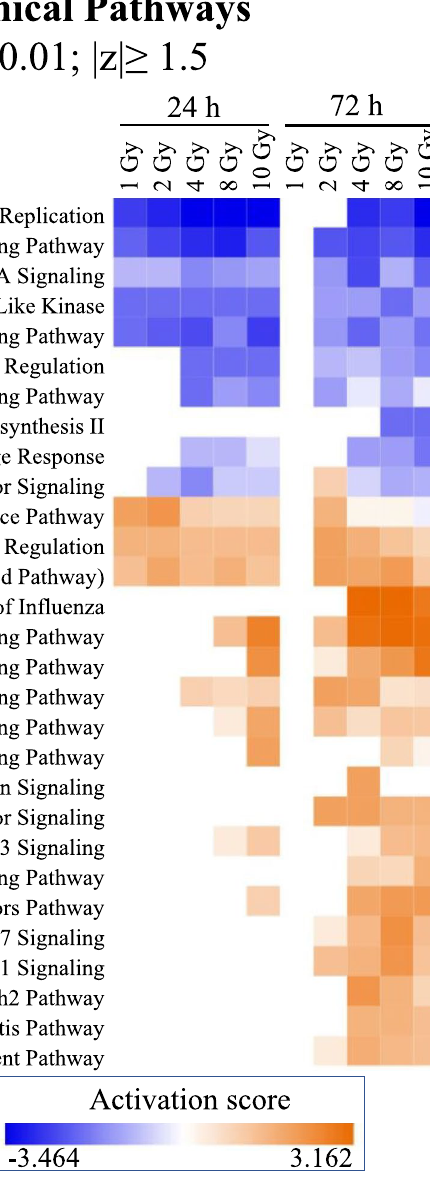
Figure 8. Comparison across canonical pathways identified in all dose-time-point combinations. Comparison was generated in IPA using the ‘comparison analysis’. Pathways passing the criteria of fisher’s test p value < 0.05 and |z-score|> 2 were